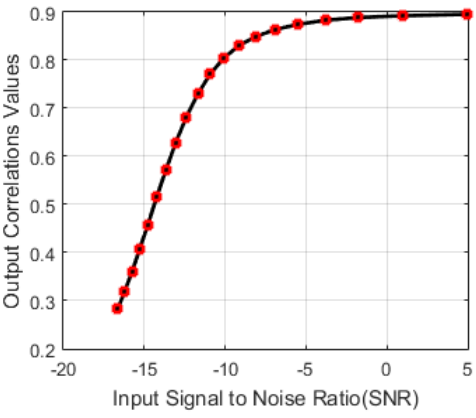
Figure 20. Output correlations values in terms of the input signal to noise ratio (SNR).